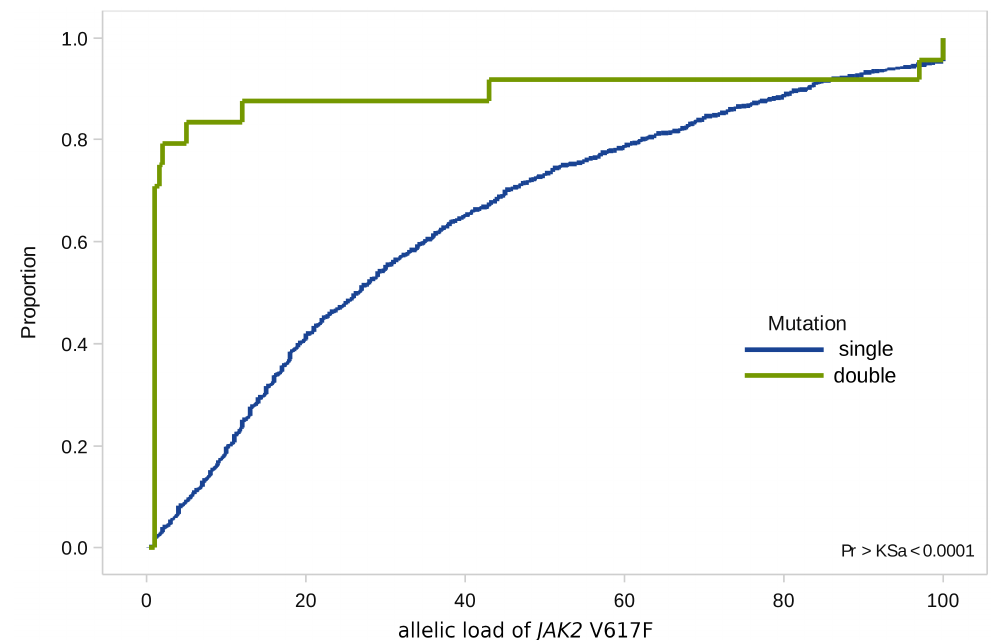
Figure 3. Empirical distributions of JAK2 V617F allele load in patients with single ( JAK2 V617F) and double ( JAK2 V617F and CALR ) mutations.